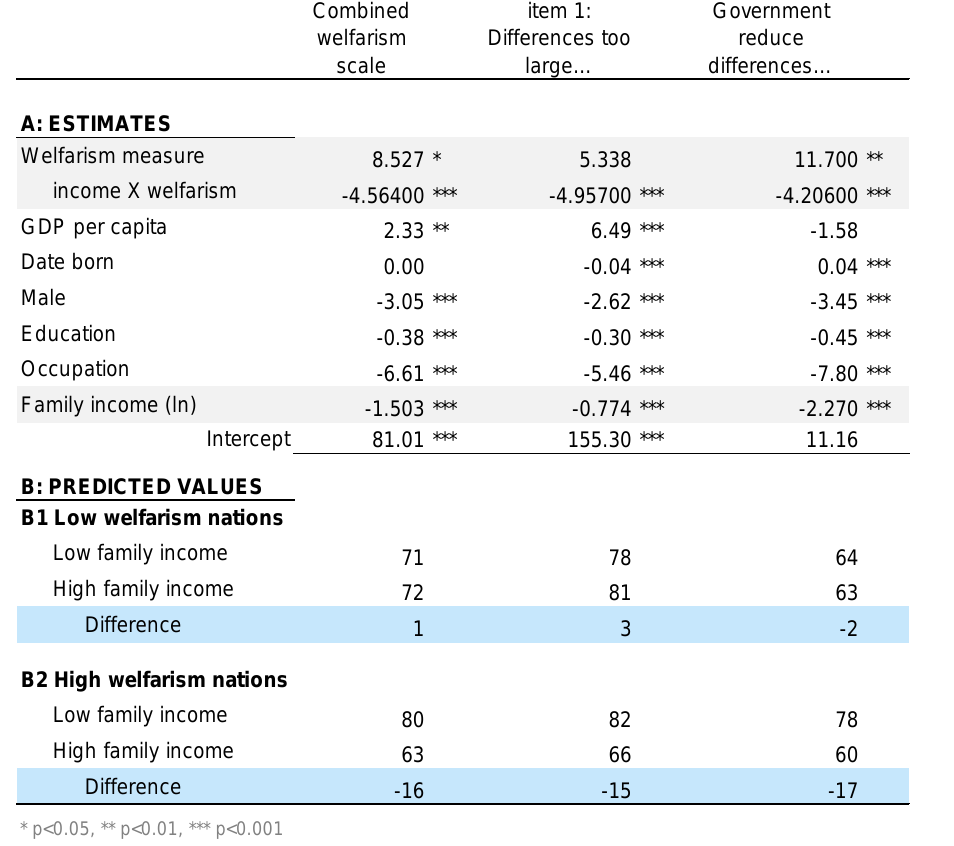
Figure A6. Effects on attitudes toward income redistribution: Cross-level interaction between welfarism and income when using alternative measures of welfarism. Using our preferred two item welfarism scale and separate estimates using each item separately give equivalent results and very similar predicted values. Metric coefficients and predicted values from multilevel regression. 30 nations, 1987–2009. Over 61,000 cases for each